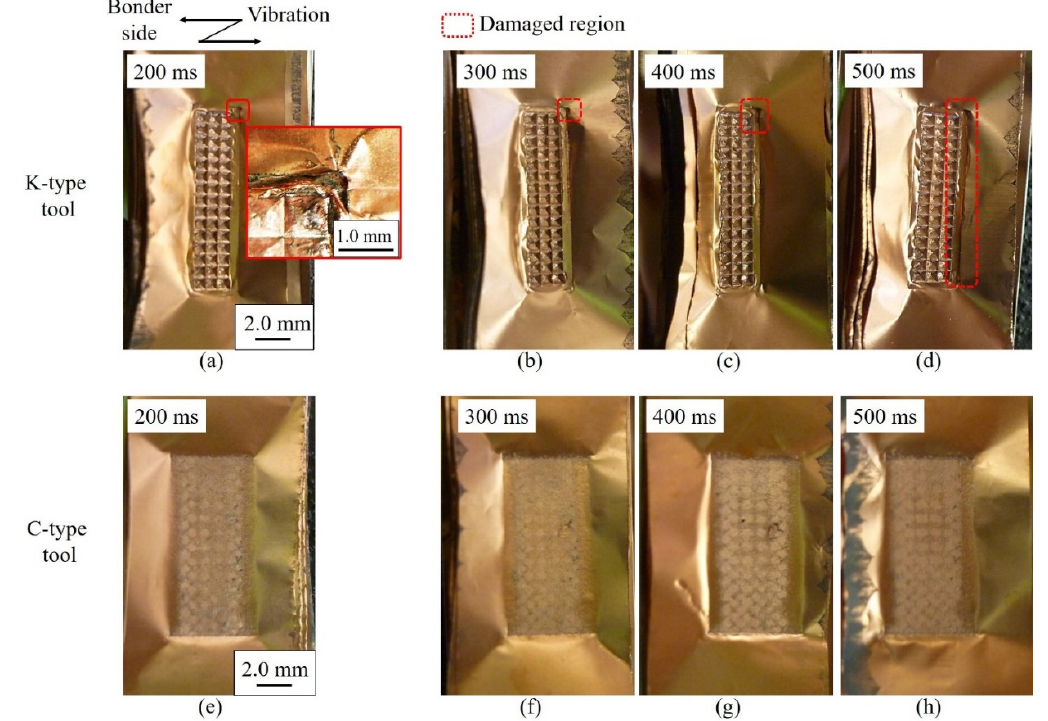
Figure 7. Appearance of bonded specimens. ( a – d ) and ( e – h ) are joints bonded with K-type tool and C-type tool, respectively.